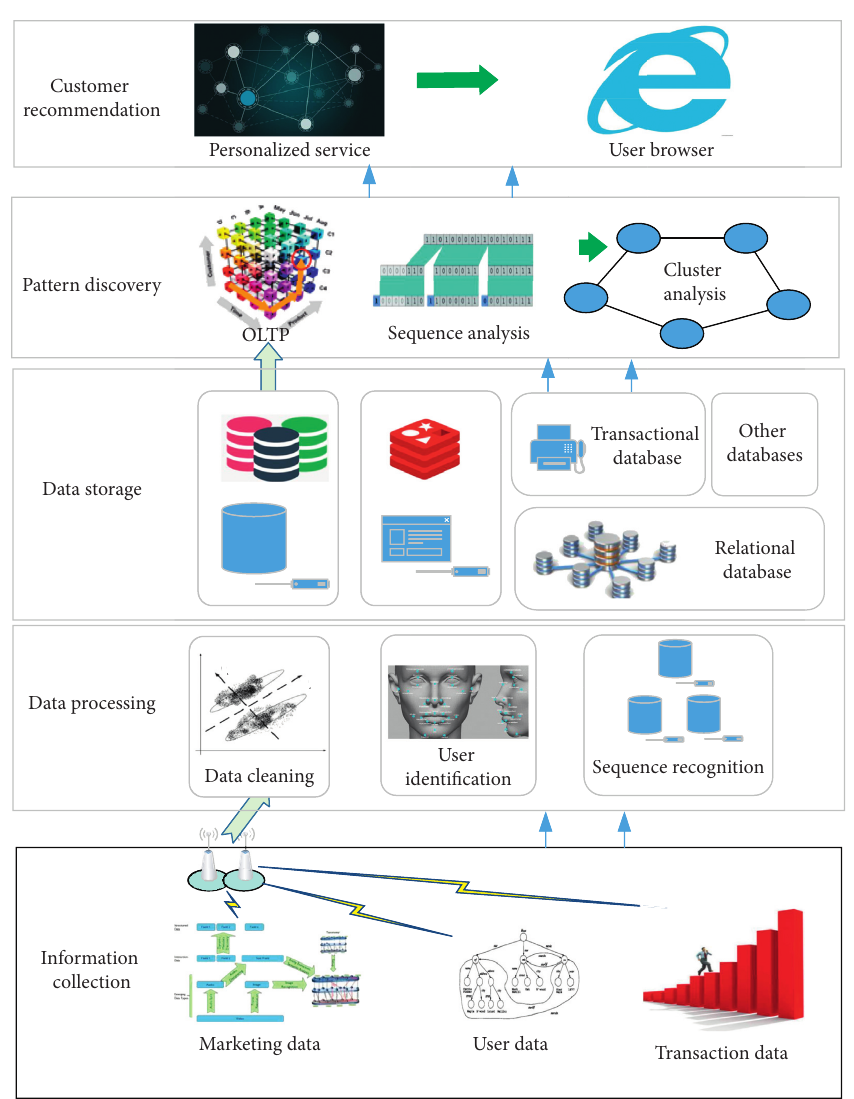
Figure 3: The structure of the cross-marketing strategy based on data mining